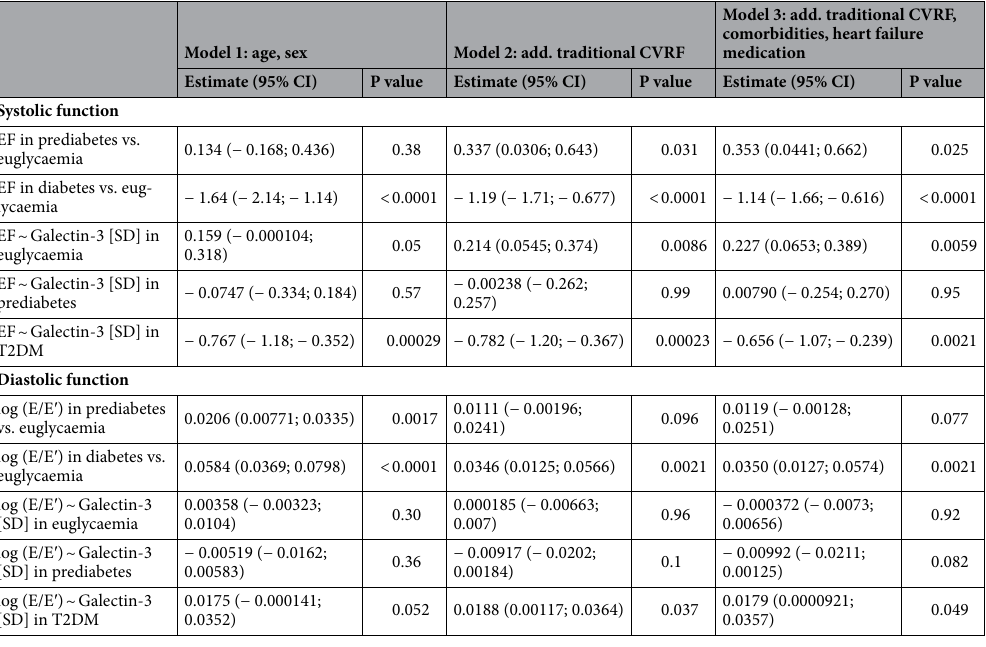
Table 3. Prospective association between galectin-3 and cardiac function in prediabetes and type 2 diabetes mellitus. Prospective analyses using multiple linear regression models for the assessment of the association between Galectin-3 (increase per standard deviation respectively 5 ng/ml) and EF as well as log(E/E ′ ) after 5 years in prediabetes and diabetes compared to euglycaemia. Individuals with impaired systolic or diastolic function were excluded from the follow-up investigation. Model 1 adjusted for sex and age. Model 2 adjusted for sex, age, hypertension, dyslipidaemia, obesity, smoking, FH of MI/Stroke. Model 3 adjusted for sex, age, hypertension, dyslipidaemia, obesity, smoking, FH of MI/stroke, atrial fibrillation, chronic kidney disease, chronic liver disease, congestive heart failure, coronary artery disease, myocardial infarction, peripheral artery disease, stroke, venous thromboembolism, heart failure medication intake. CVRF cardiovascular risk factors, SD standard deviation, T2DM type 2